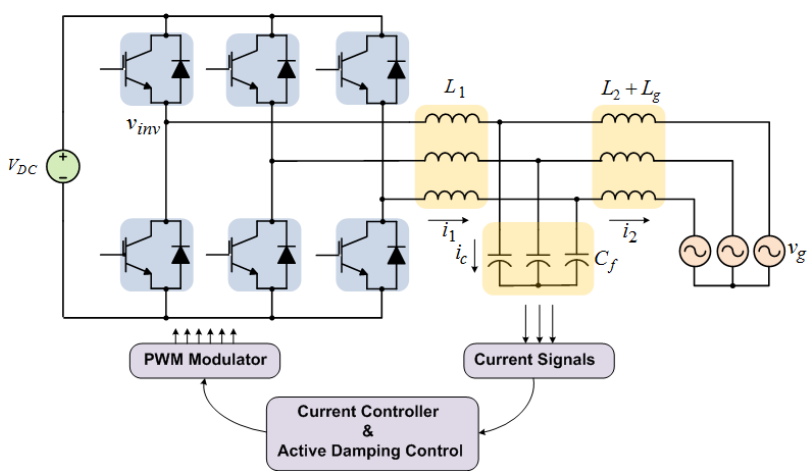
Figure 2. LCL-filter-based grid-connected three-phase inverter structure.